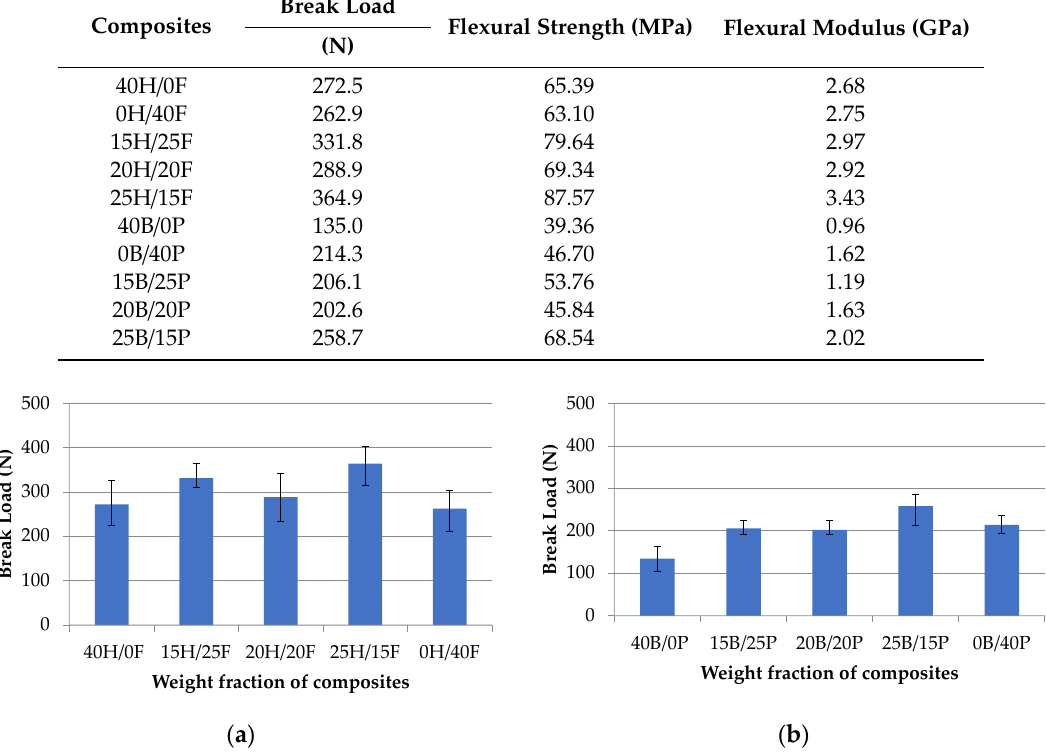
Figure 6. Break load vs. weight fraction of hemp / flax (H / )F composites ( a ) and banana / pineapple (B / P) composites ( b ).